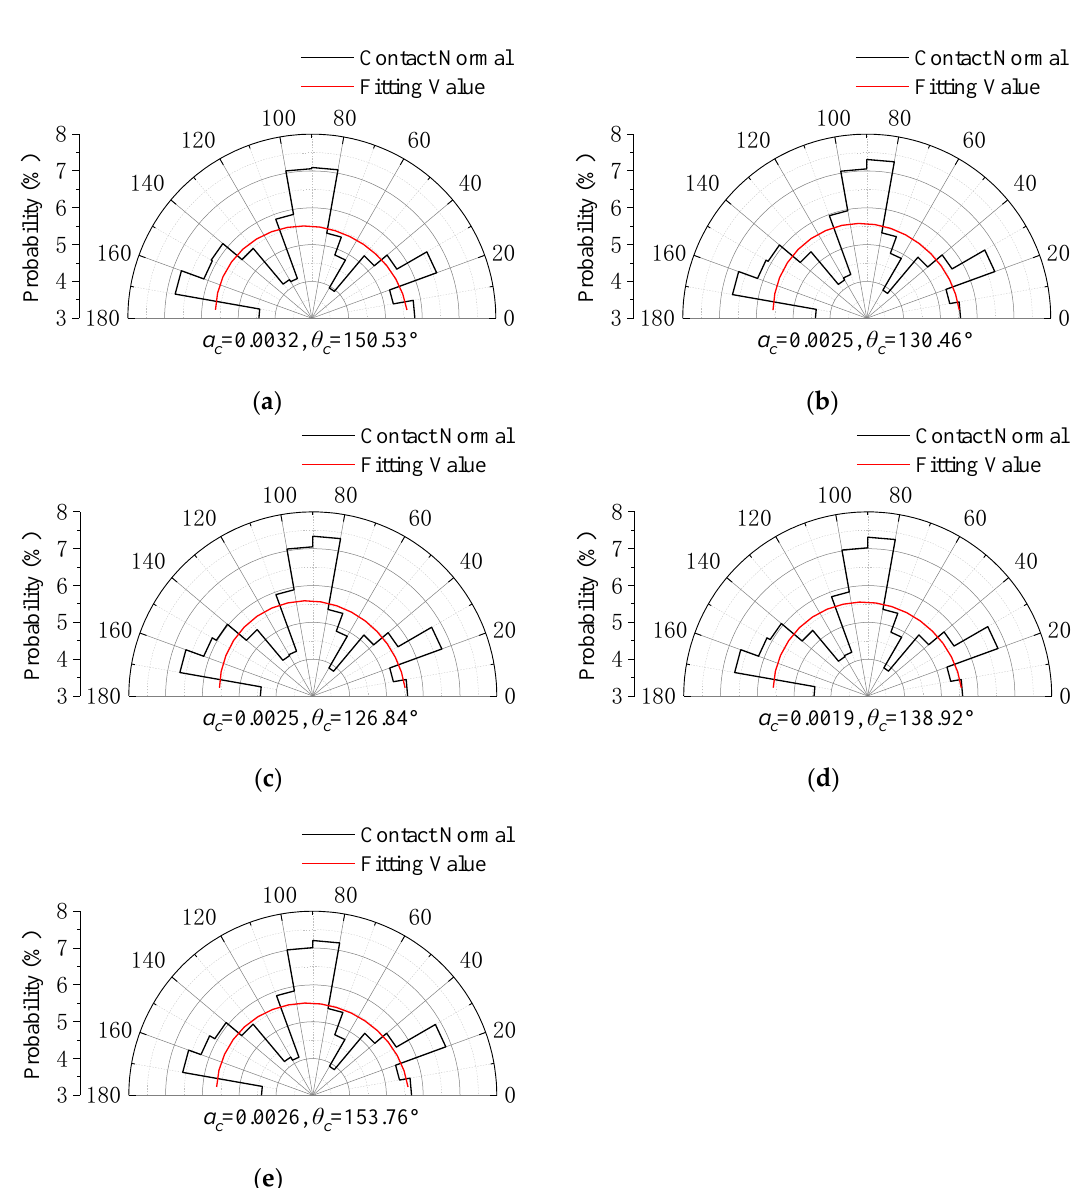
( b ) Figure 8. Gradual development with different loading state: ( a ) stress-strain relationship; ( b ) coordination number. In the mesostructure of granular materials, its anisotropy is also a fundamental property and has a certain degree of stress correlation. To this end, this study describes the anisotropy of the specimen by measuring the distribution characteristics of the normal direction of contact between particles. It is generally considered that the contact normal distribution E ( θ ) satisfies the form of the second-order Fourier function, see Equation (9). Figure 9 shows the anisotropy change during loading. As the bias stress increases, the principal direction angle of the contact normal changes significantly and approaches the principal stress direction of the specimen. From state A to state C, θ c decreases monotonically; from state C to state E, θc increases monotonically. It can also be seen from the figure that with the increase of deviator stress, the anisotropy coefficient of the test piece has been at a low value and the change is relatively small. At the same time, combined with the anisotropic distribution image, the results show that the anisotropy inside the specimen under low stress depends mainly on the anisotropy of the crushed rock, which is mainly related to the shape and distribution of the particles [36]. However, in triaxial tests, the effect of stress-induced anisotropy is small. Therefore, in the resilient behavior of SRM, it is crucial to consider the structural characteristics of the crushed rock. Further research should consider the influence of shape variability on the performance of